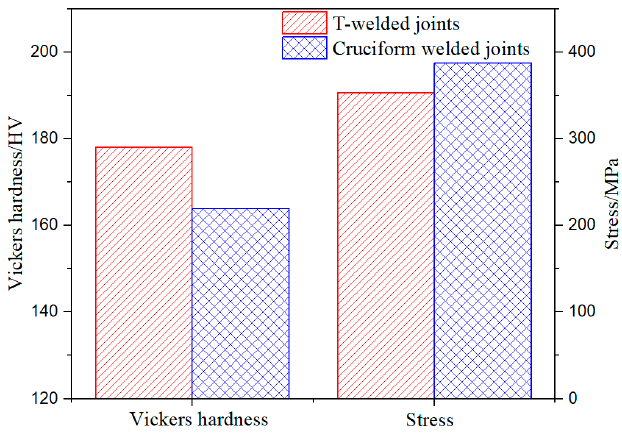
Figure 14. The stress and Vickers hardness in the failure zone.